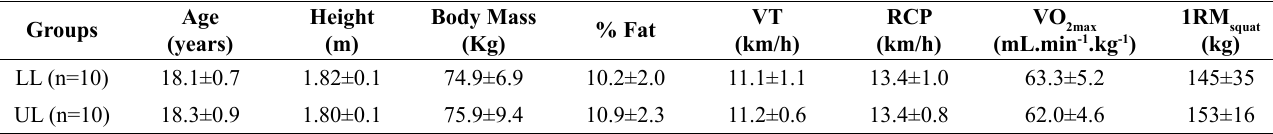
Table 1. Sampling of descriptive features (mean ± SD).*